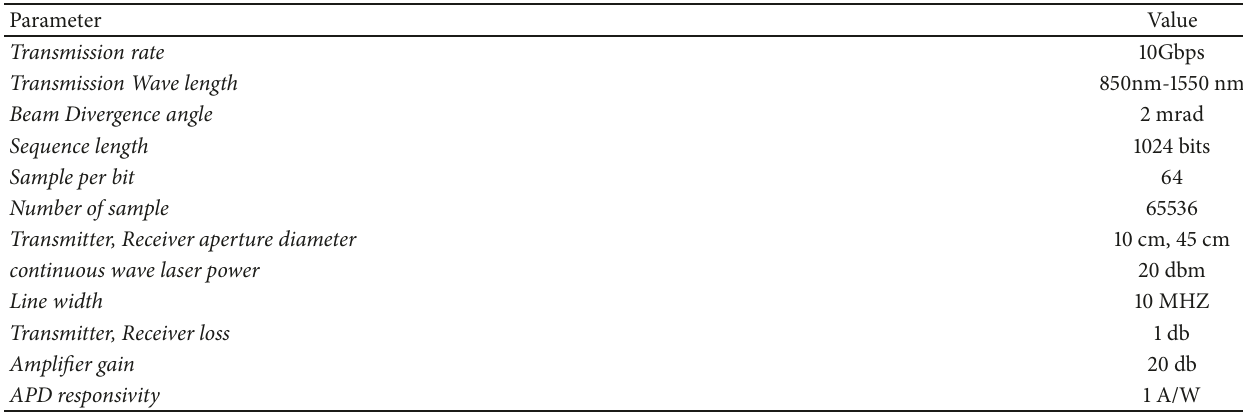
Table 1: Global parameter setup.